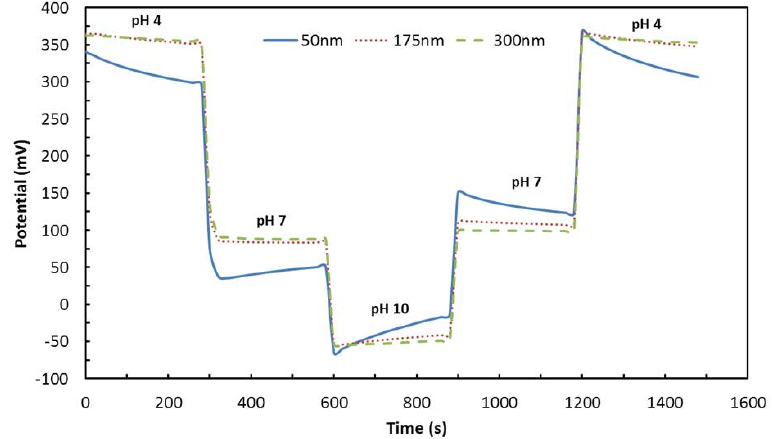
Figure 6. Measured average potential versus time in pH loop (4-7-10-7-4) for different RuO 2 film thickness. Reprint with permission from [21]. Copyright 2014